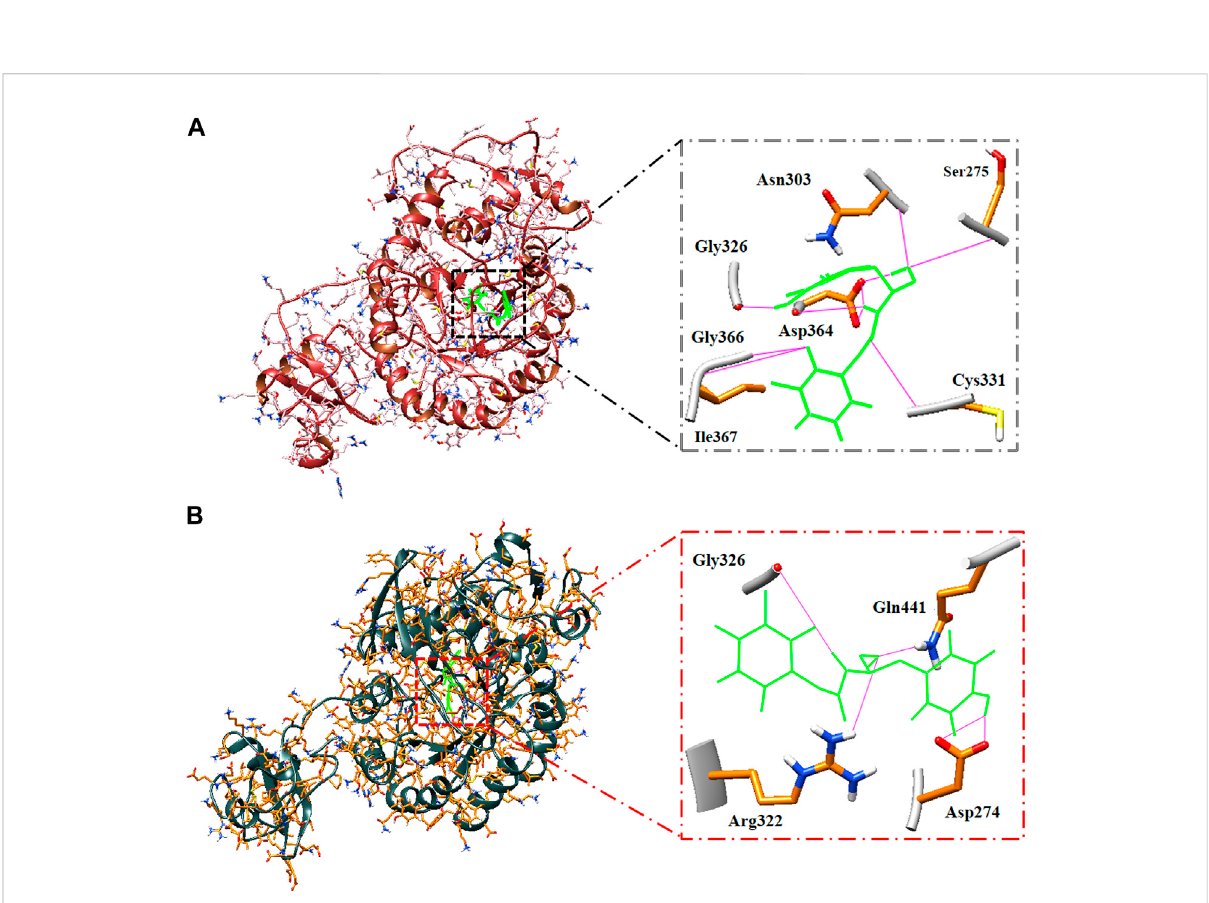
FIGURE 5 Binding pose and hydrogen bonds of best hit ligand during MD simulation. Type 1 (A) and type 2 (B) hIMPDH along with its involved residues (highlighted in the fi gure) in hydrogen bonding in complex with Zinc355749373.